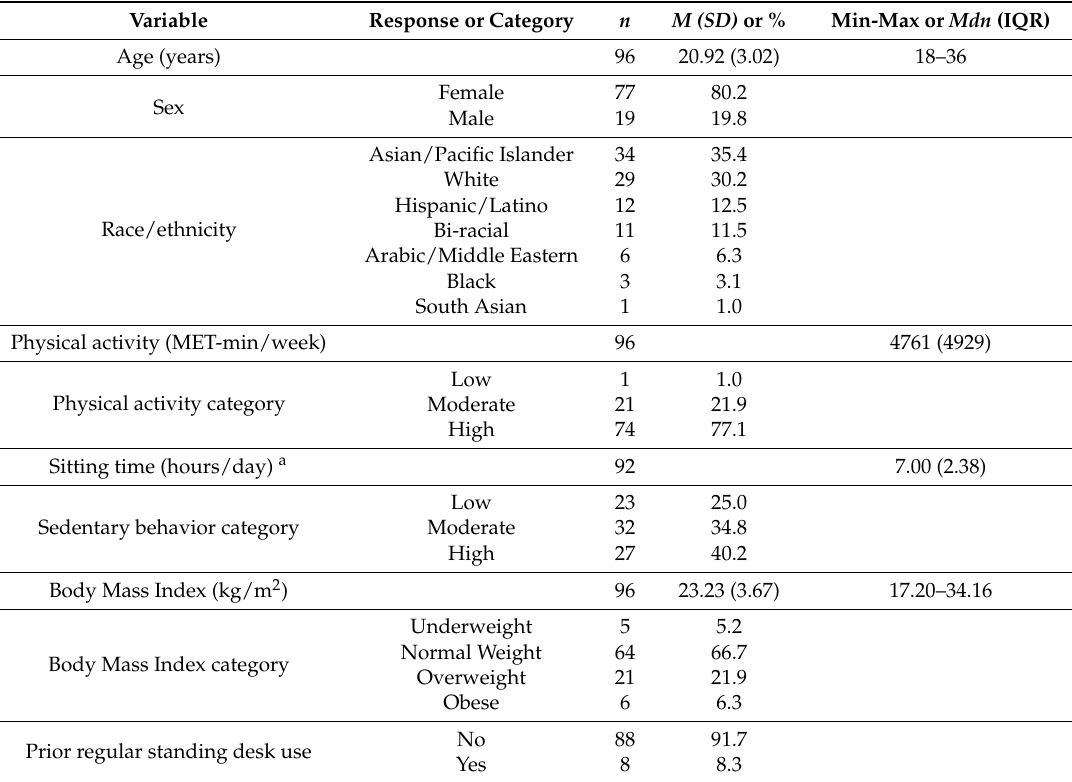
Table 2. Participant Demographic